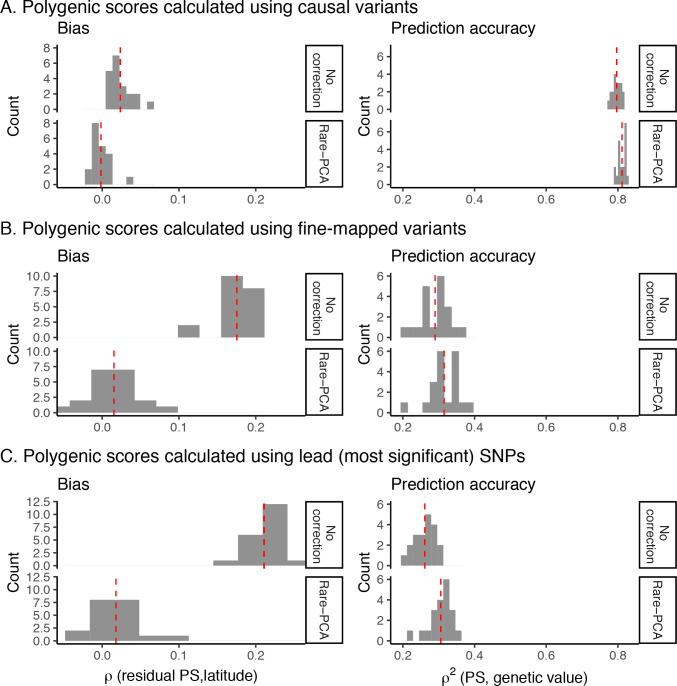
Bias and prediction accuracy in polygenic scores as a function of variant ascertainment schemes.Polygenic scores were calculated using (A) causal variants with p-value < 5e-04, (B) variants fine-mapped with SuSiE in windows where at least one variant has a p-value < 5e-04, and (C) the most significantly associated variants in windows where at least one variant has a p-value < 5e-04. Results presented here are based on the recent structure model. Bias is measured by the correlation between polygenic score and latitude (the confounding environmental effect) and prediction accuracy is measured by the proportion of variance in genetic value of an individual explained by their polygenic score. Red dashed lines represent the observed mean of the distribution.